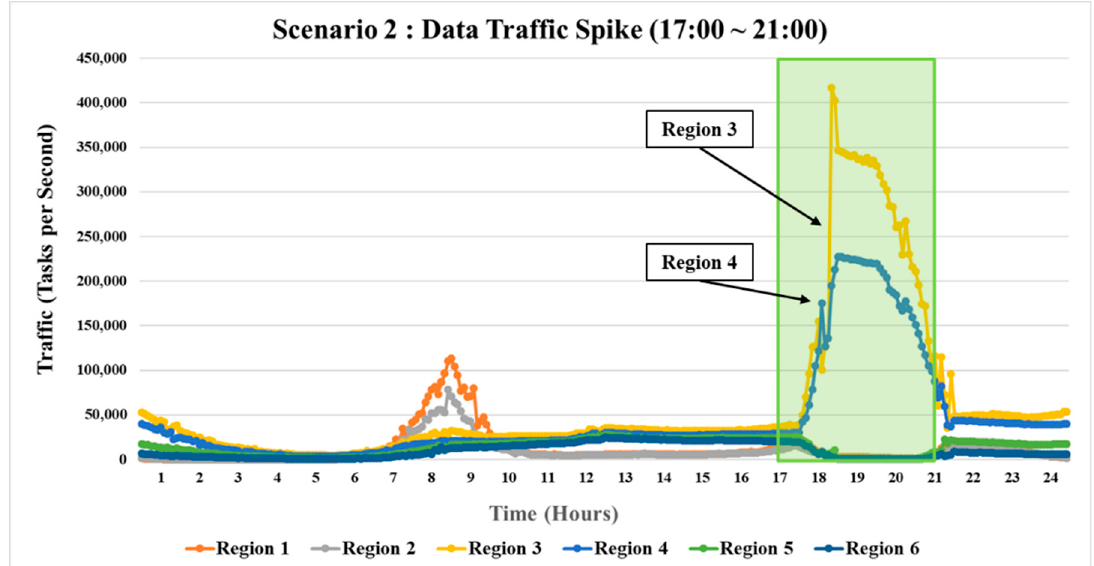
Figure 8. Twenty-four hour data traffic patterns for Scenario 2: regional data traffic spike.